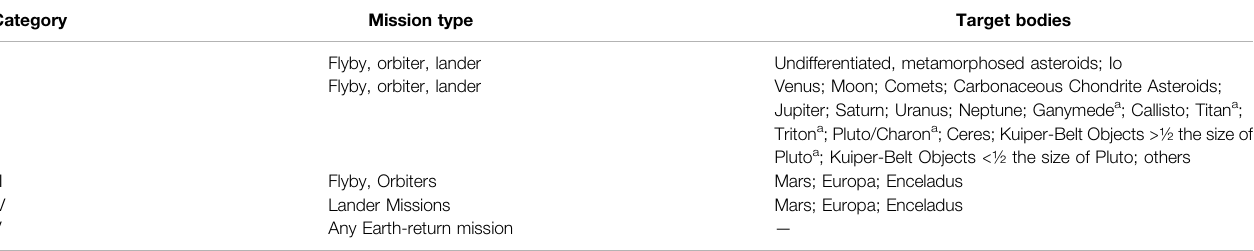
TABLE 1 | Categories of missions and target as stated in (COSPAR